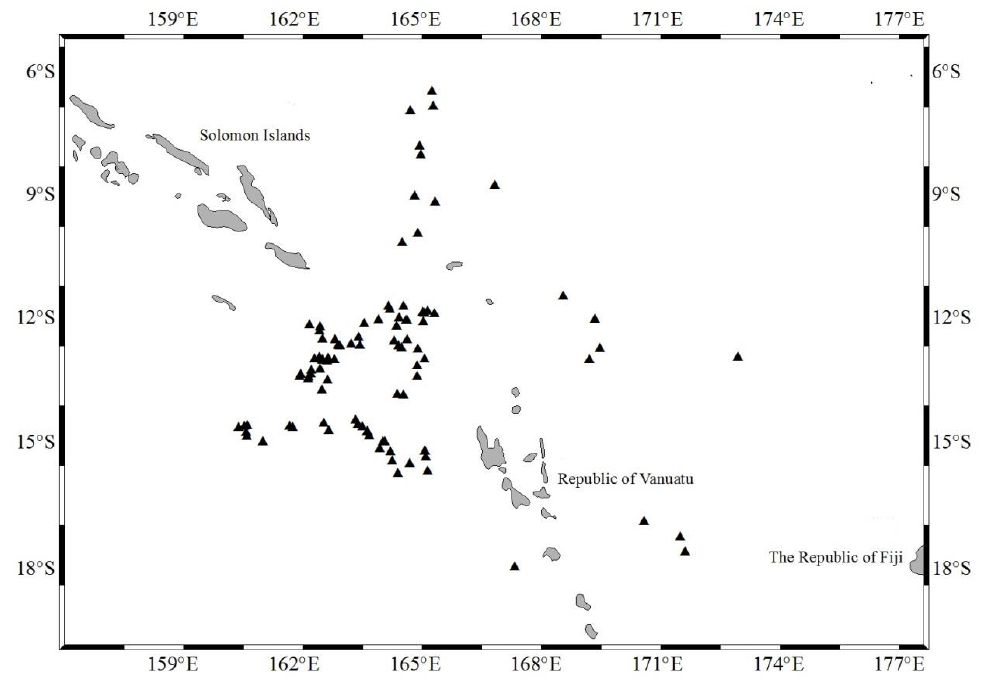
Figure 1. Set locations where wahoo specimens were sampled in the Western and Central Pacific Ocean (WCPO).